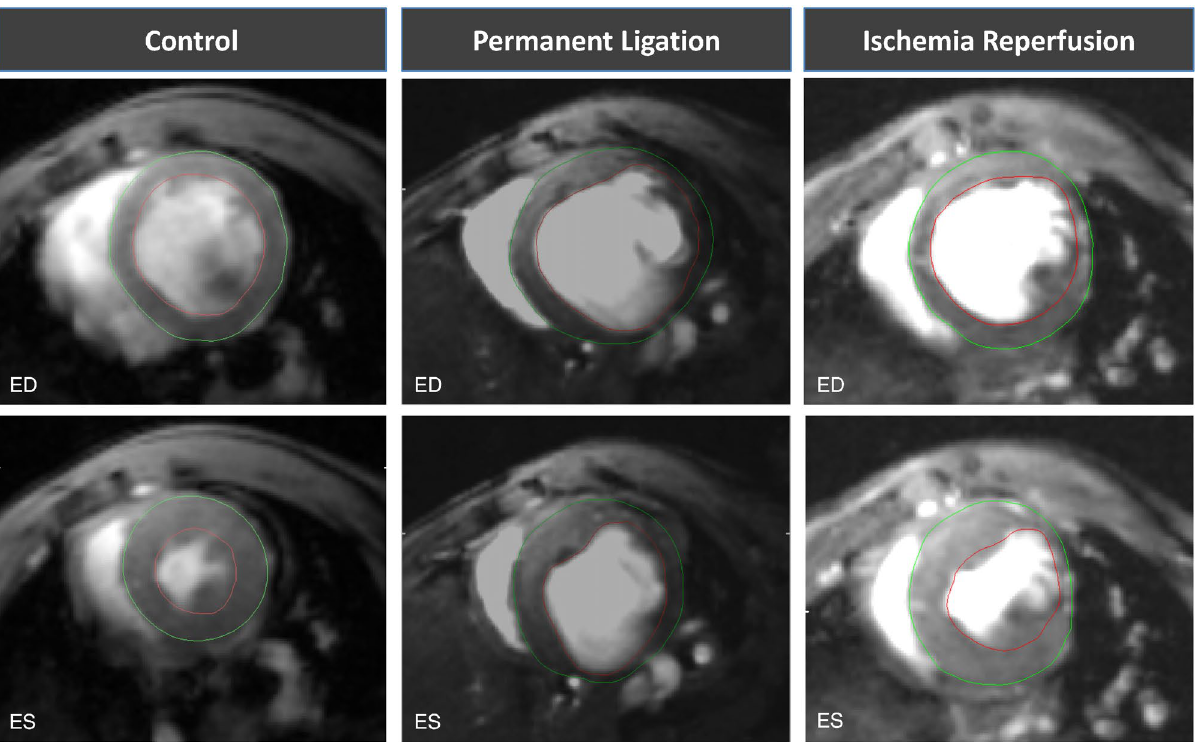
Figure 2. Representative mid-ventricular slices of healthy (control) and infarct animals 3 weeks following MI induction. Upper row: end-diastolic (ED) slices. Lower row: end-systolic (ES) slices. The epicardium is marked with a green line, the endocardium with a red line. Papillary muscles were